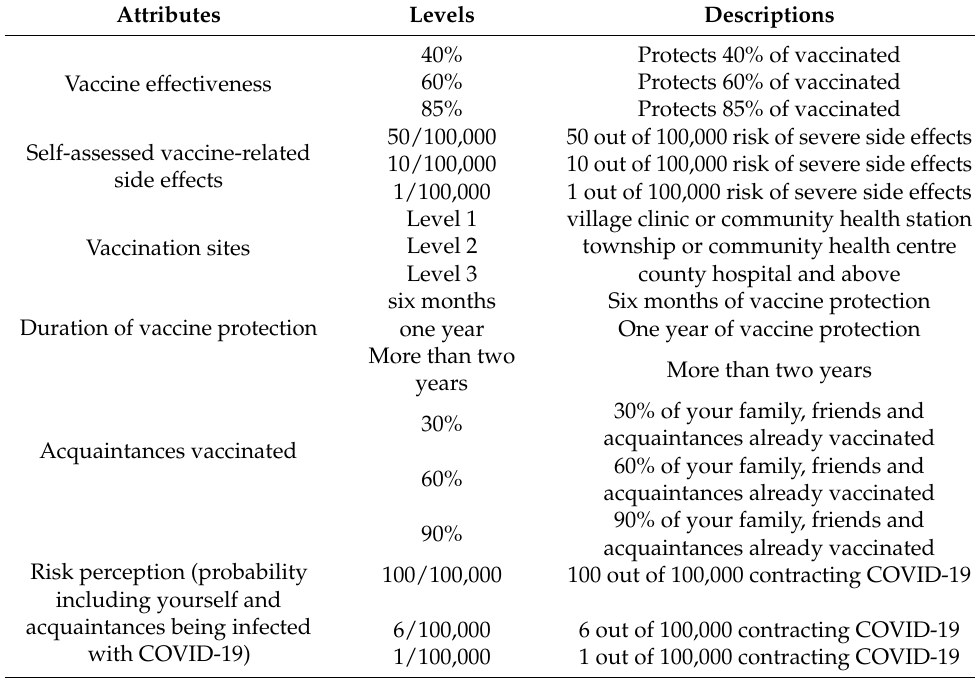
Table 1. Attributes and Levels Used in the Discrete Choice Experiment. Attributes Levels